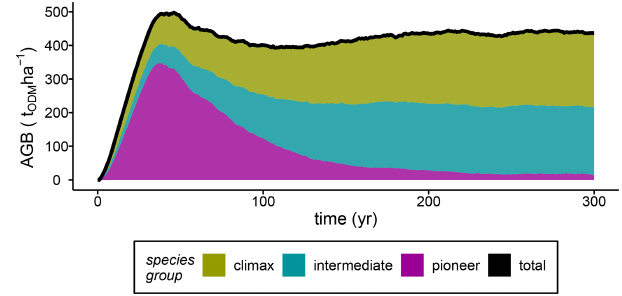
Figure 2. The baseline scenario’s aboveground biomass (AGB) per species group and the total biomass for simulations of terra firme forests (ODM: organic dry